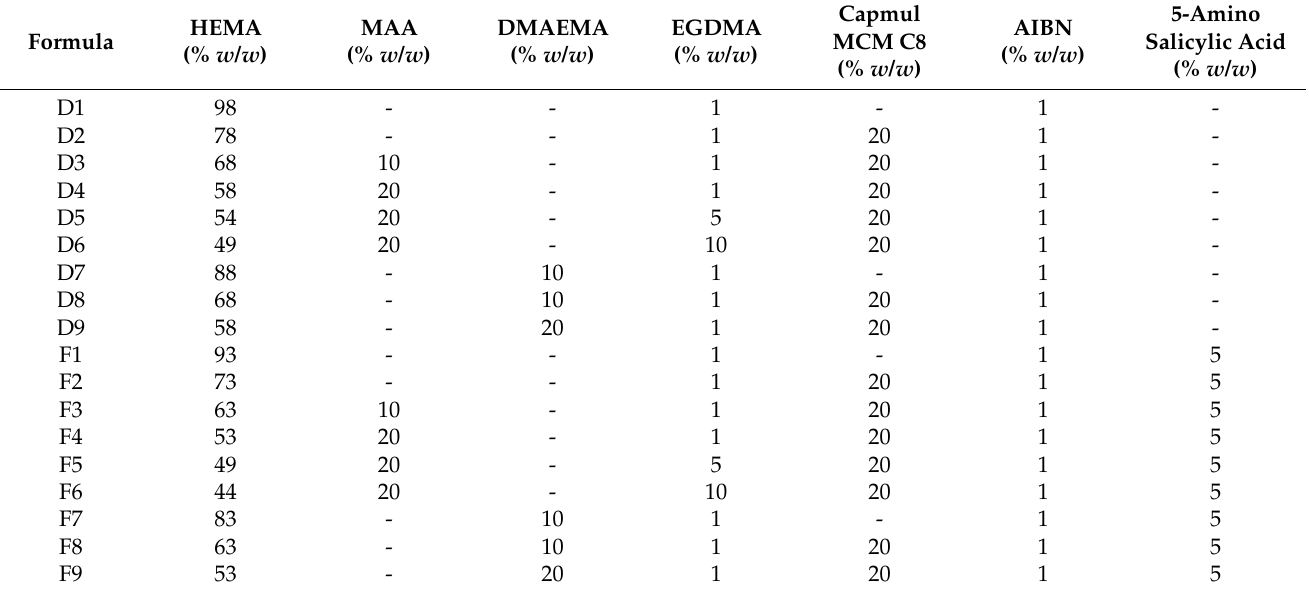
Table 1. The compositions of the synthesized copolymerized